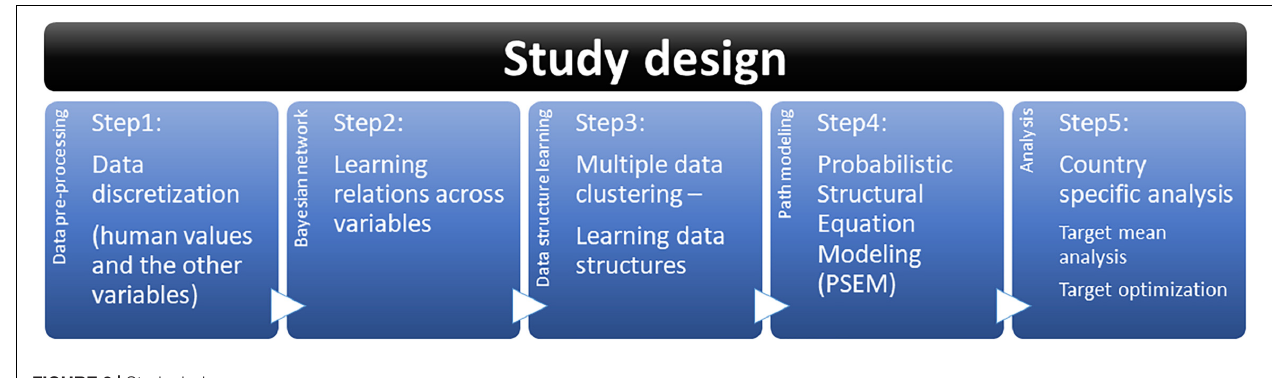
FIGURE 3 | Study design. TABLE 2 | Fit performance of the multi-group invariance